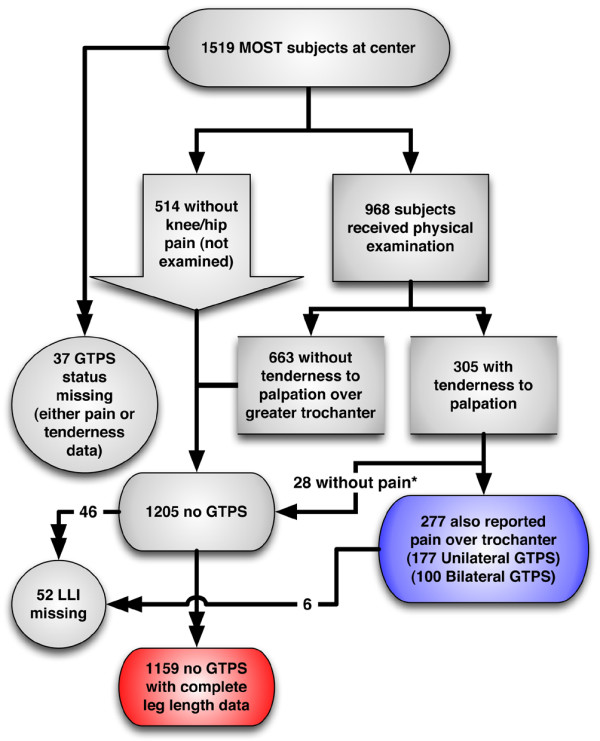
Subject recruitment and group disposition. *Did not meet definition for greater trochanteric pain syndrome (GTPS). LLI, leg-length inequality; MOST, Multicenter Osteoarthritis Study.